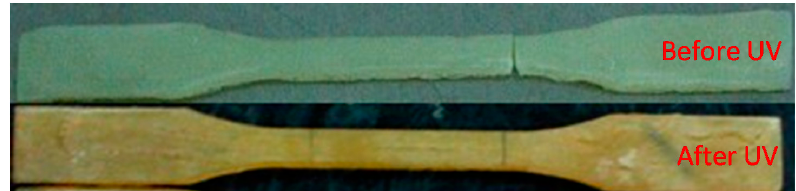
Figure 11. Comparison of physical changes of resin adhesive specimens before and after UV exposure.